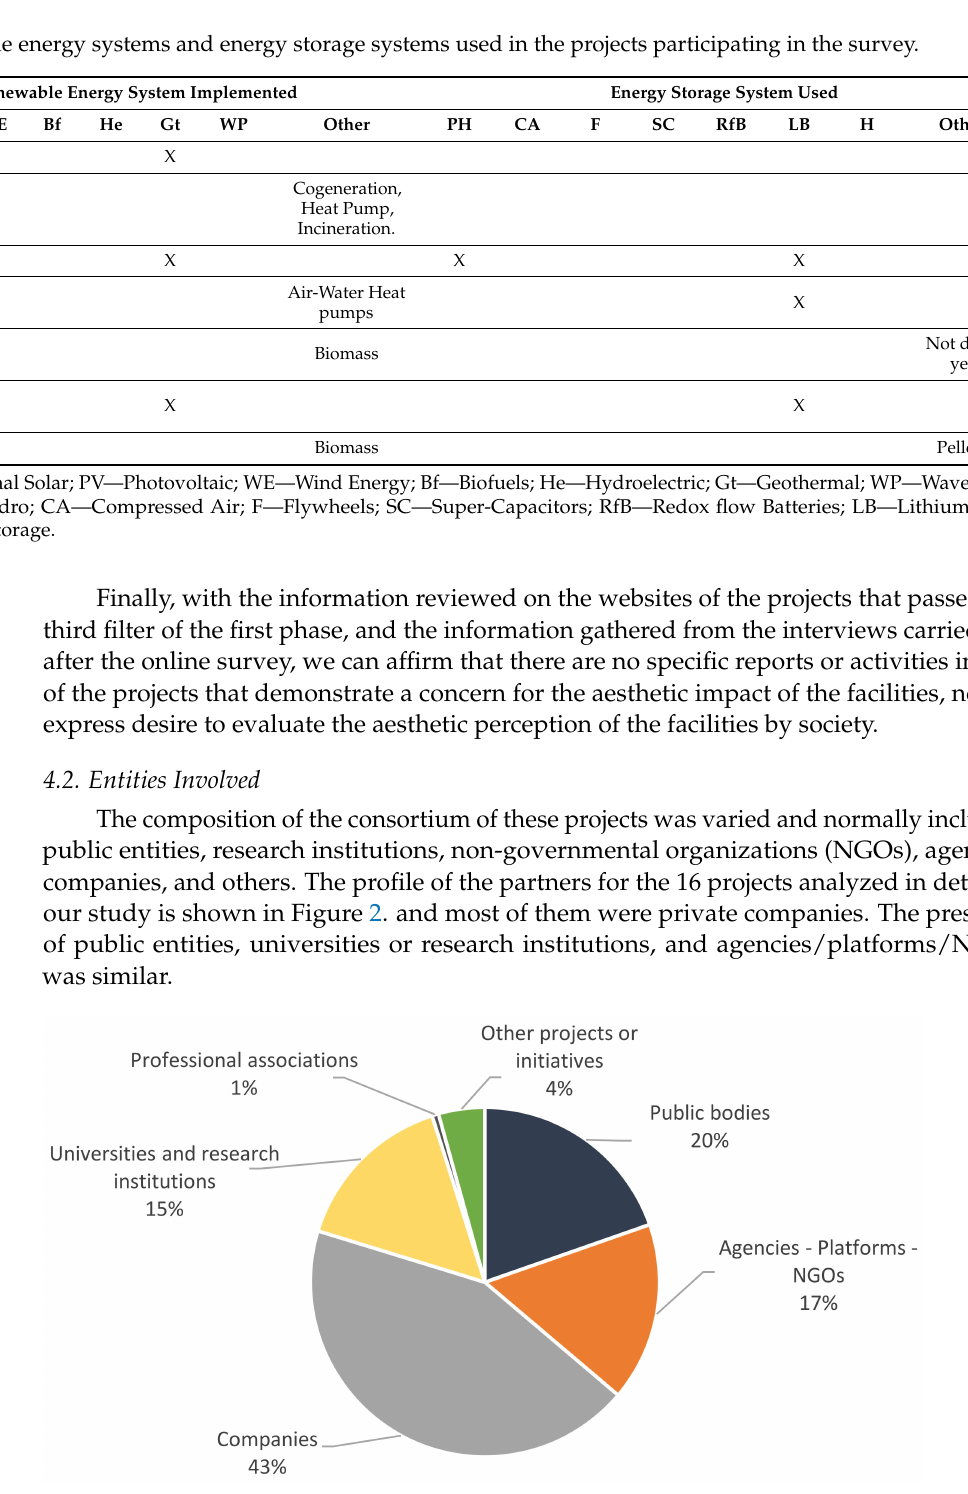
Figure 2. Profile of the partners in the European projects